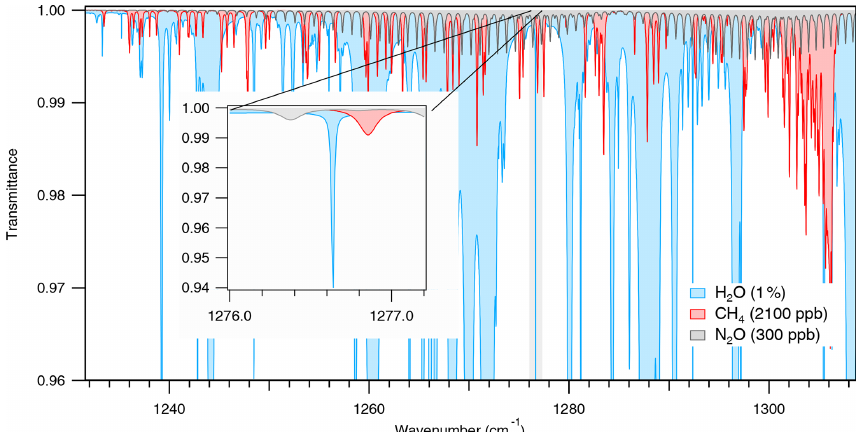
Figure 1. Simulated transmission spectrum of ambient air at atmospheric pressure over an optical path length of 10m. Only the contributing molecular species, e.g., H 2 O, CH 4 , and N 2 O, with their mean atmospheric abundance are considered. The inset shows the selected spectral window for methane measurements. The water absorption line is markedly narrow, due to a particularly small pressure-broadening coefficient of this